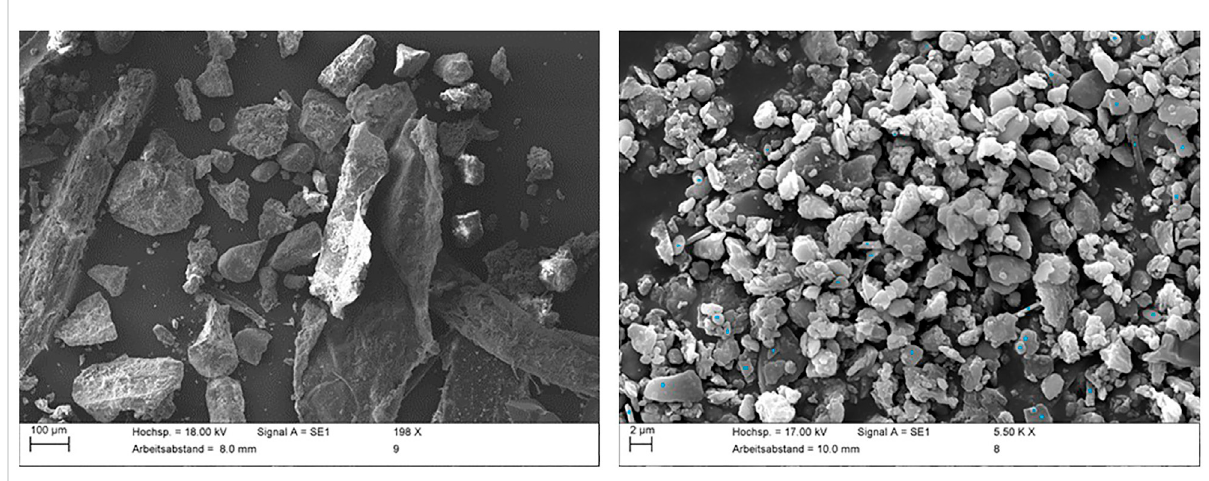
FIGURE 4 SEMimagesofthecoarseand fi nefractionsofthesampleddust;leftimageshowsbigparticlesoforganicorigin,intherightimagearephytoliths marked with blue dots.